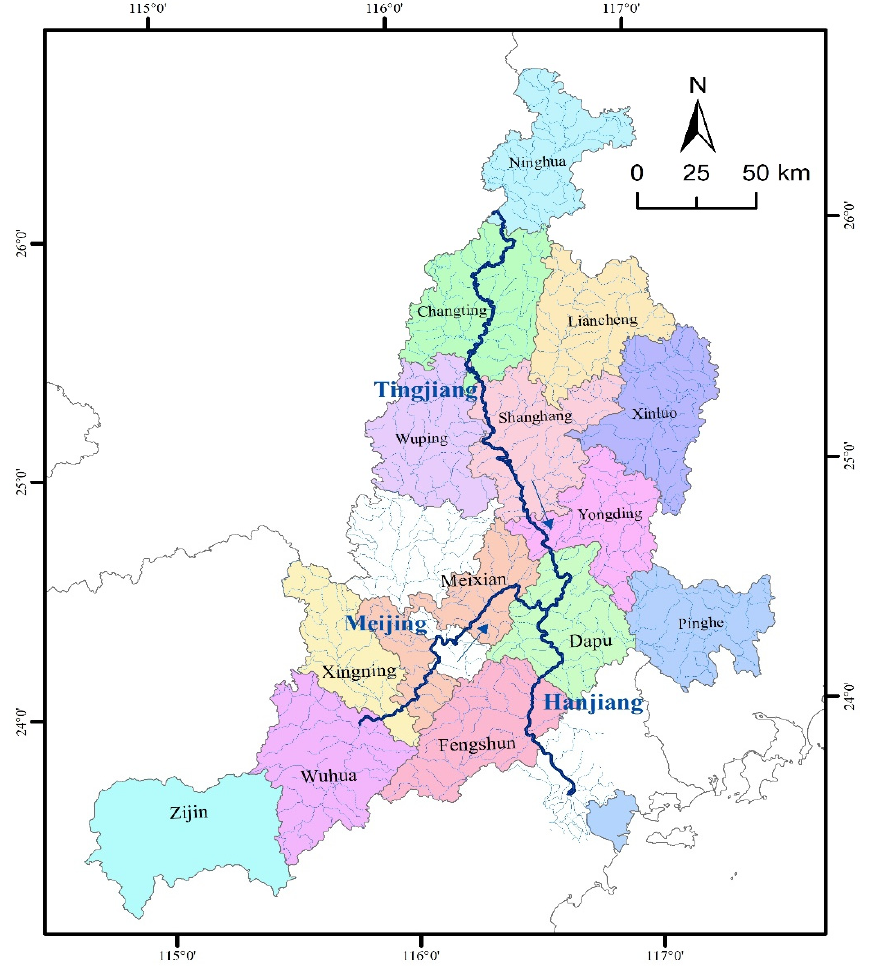
Figure 1. Natural situation of the Tingjiang River.